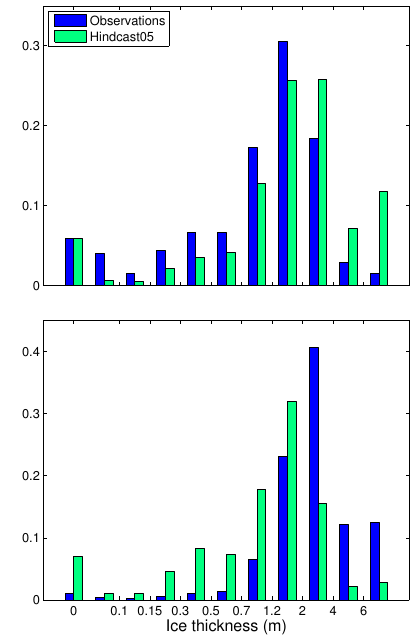
Figure 15. Average ice thickness distributions from ULS measure- ments (blue) and hindcast H05 (green) at the Beaufort Gyre Explo- ration Project (BGEP) mooring A (top) and at the North Pole Envi- ronmental Observatory mooring (bottom). The BGEP mooring data were averaged for the period September 2003 to December 2009. The NPEO mooring data were for the period January 2003 to De- cember 2009 (but there are some gaps in the record). In each case the model output is averaged for the same period as the observa-